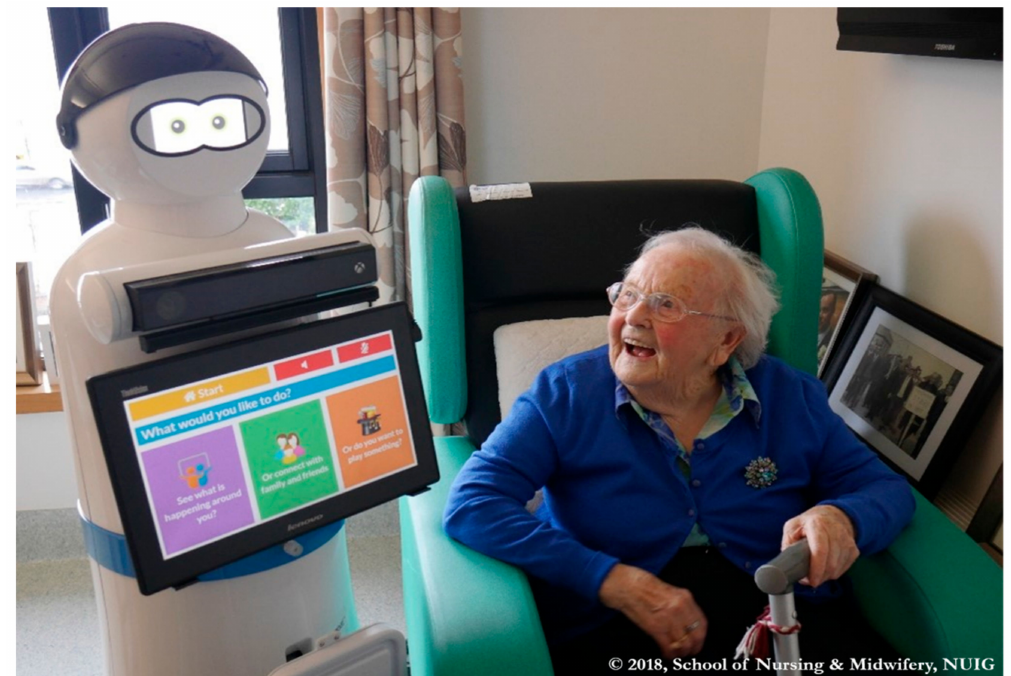
Figure 1. A resident of the nursing home in Ireland interacting with the MARIO social robot as part of her daily routine. (The first author has copyright of this